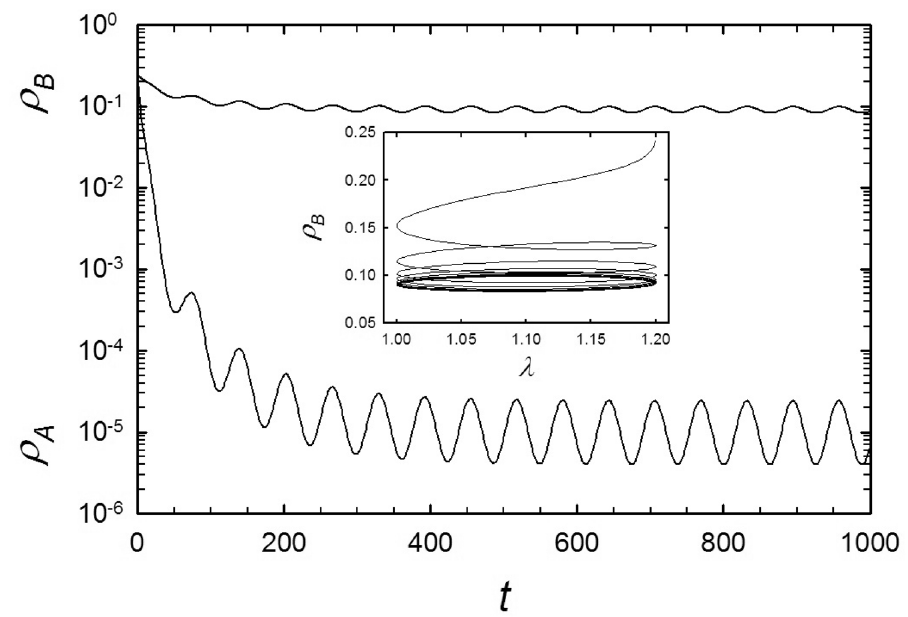
Fig 5. MF equations with periodic λ : Population densities ρ B (upper) and ρ A (lower), versus time, for λ 0 = 1.1, r = 0.1, ω = 0.1 and α = 0.1. The inset shows ρ B ( t ) versus λ ( t ), with an initial transient followedby a periodicorbit.